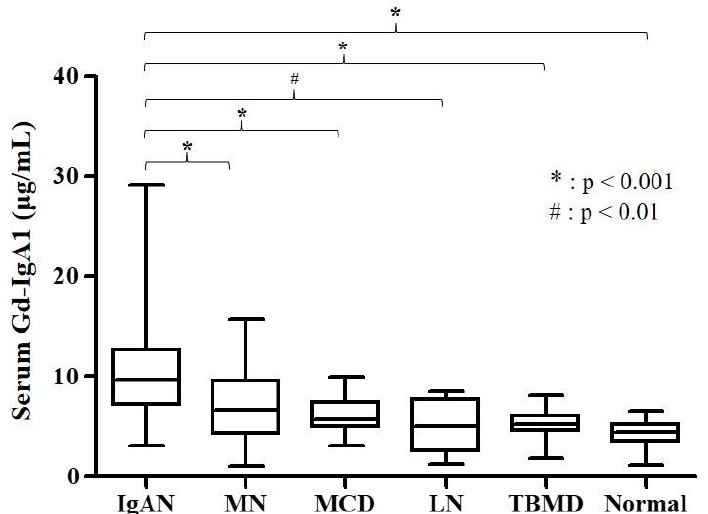
Figure 1. Serum Gd-IgA1 levels according to type of glomerular disease. IgAN, IgA nephropathy; MN, membranous nephropathy; MCD, minimal change disease; LN, lupus nephritis; TBMD, thin basement membrane disease; Gd-IgA1, galactose-deficient IgA1. *: p < 0.001 and #: p < 0.01. Multiple comparisons for the level of serum Gd-IgA1 was performed by a Bonferroni significant di ff erence test. Box plot shows median, first and third quartiles, minimum and maximum.